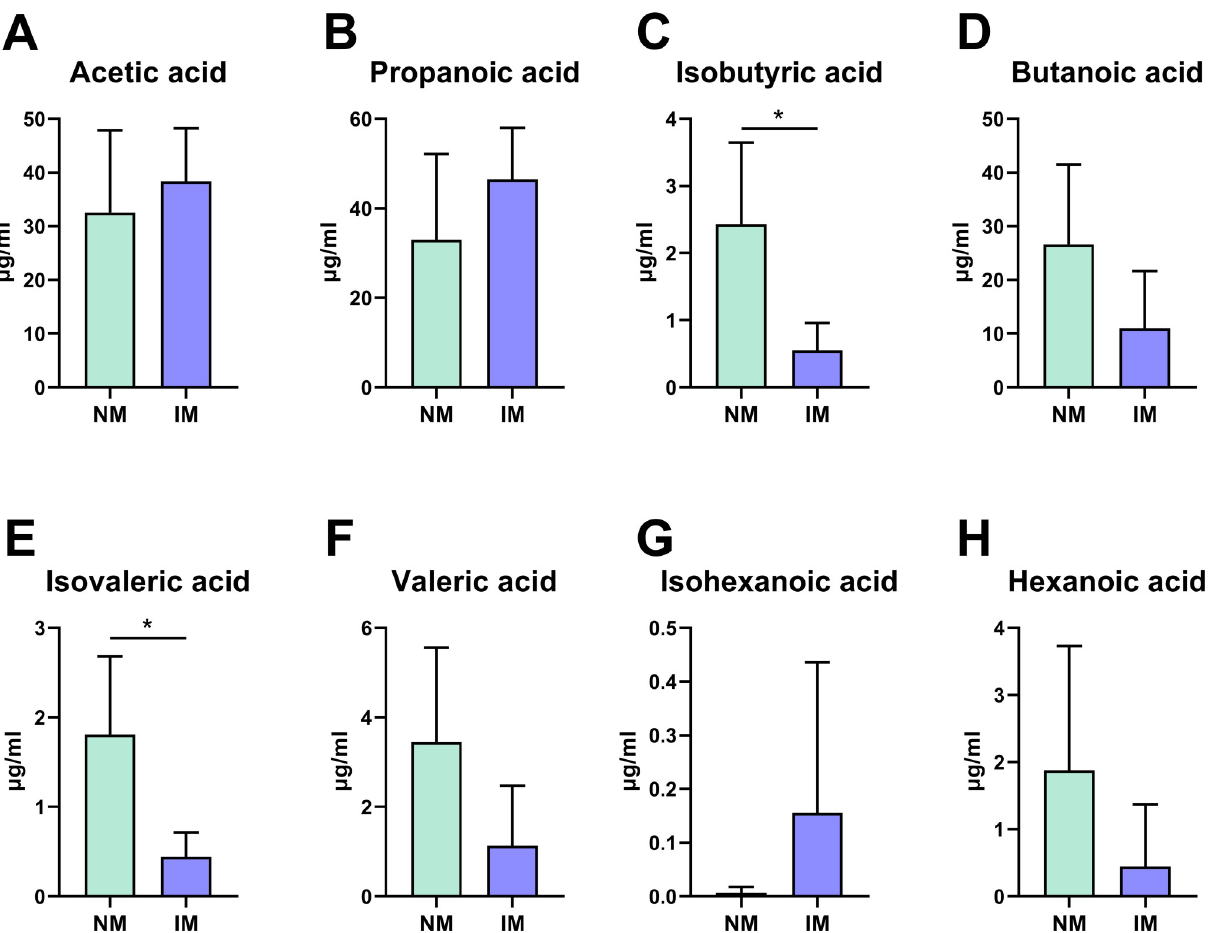
Fig 2. Analysis of short-chain fatty acid content in feces of maternal rats. (A-H) Quantitative analysis on short-chain fatty acids in maternal feces at E18.5.